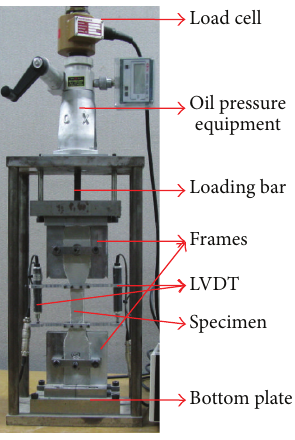
Figure 2: Direct tensile test